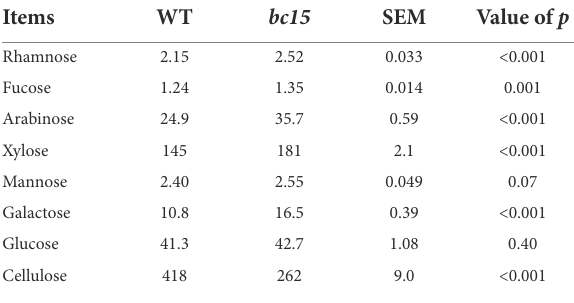
GE, Gross energy. TABLE 3 Cell wall composition of wild-type (WT) and brittle culm 15 ( bc15 ) mutant rice straws (expressed in g/kg of DM; N = 3).